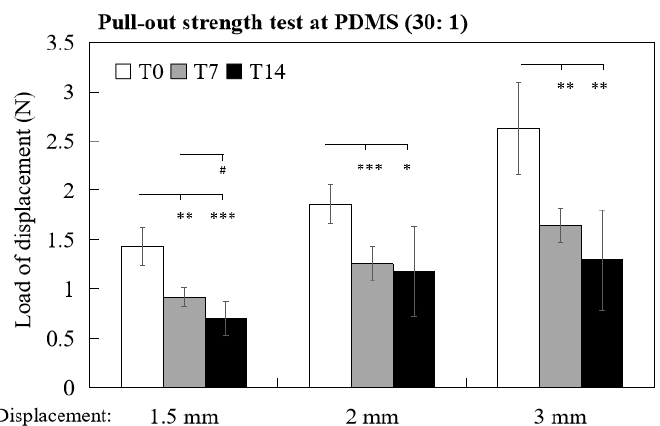
Figure 6. Comparison of average load (N) of 1.5 mm, 2 mm and 3 mm displacement from T0 (white bars), T7 (gray bars) and T14 (black bars) barbed threads by pull-out test with PDMS (30:1) specimen. * p < 0.05, ** p < 0.01 and *** p < 0.001 when compared with T0 samples; # p < 0.05 when compared with T7 samples.